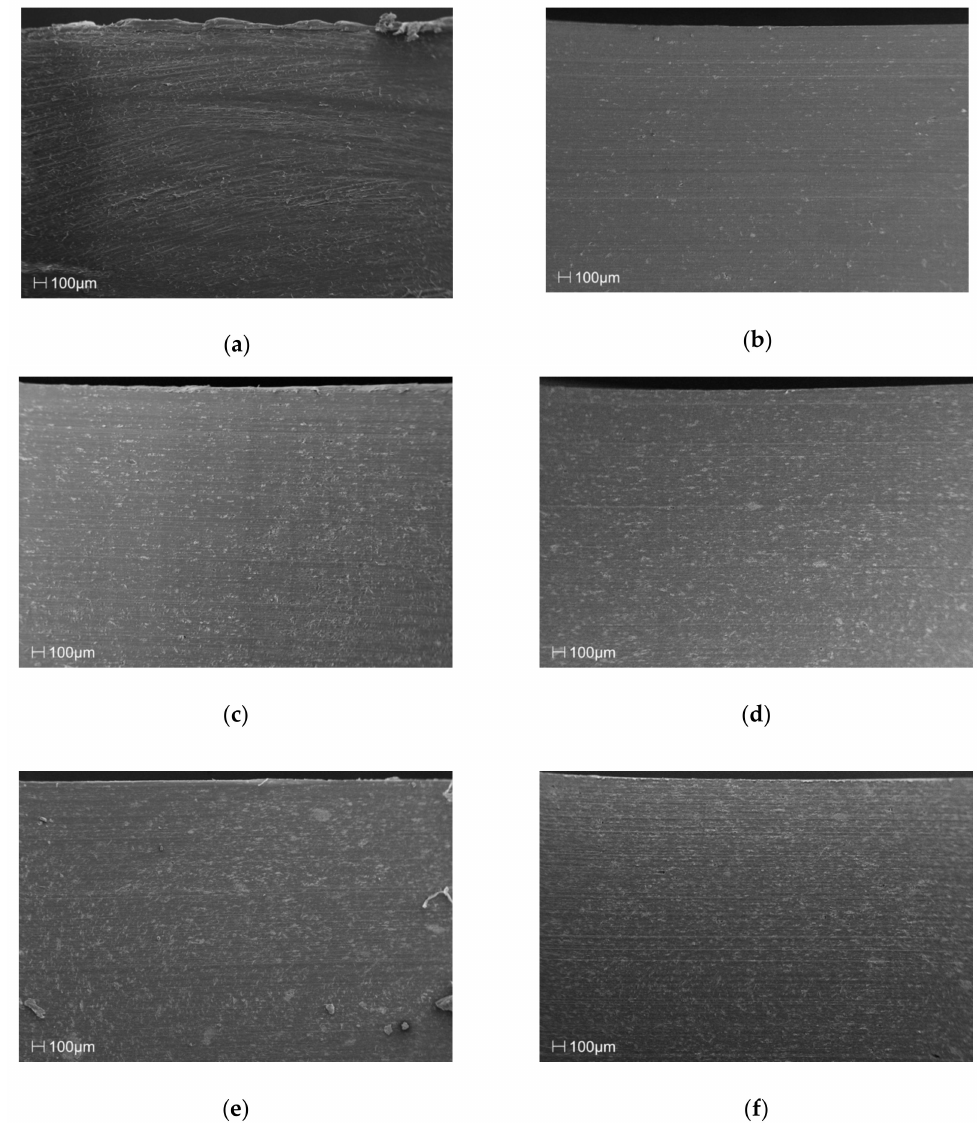
Figure 2. SEM images of the cross-section surface layer for polypropylene (PP) samples with ( a ) 0%, ( b ) 5%, ( c ) 10%, ( d ) 15%, ( e ) 20% and ( f ) 25% talc